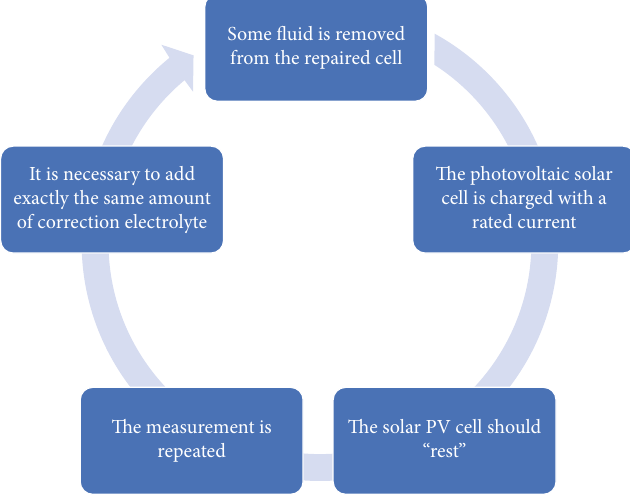
Figure 3: Necessary to implement the proposed procedures.